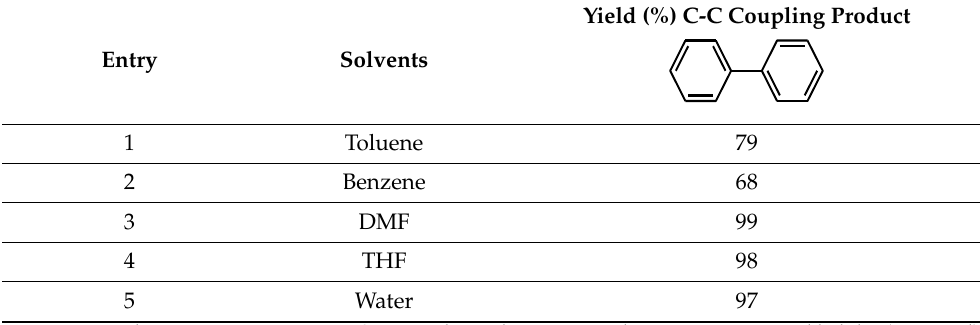
Table 1. The effect of different solvents on the yield for the C-C Ullmann coupling reaction using 5